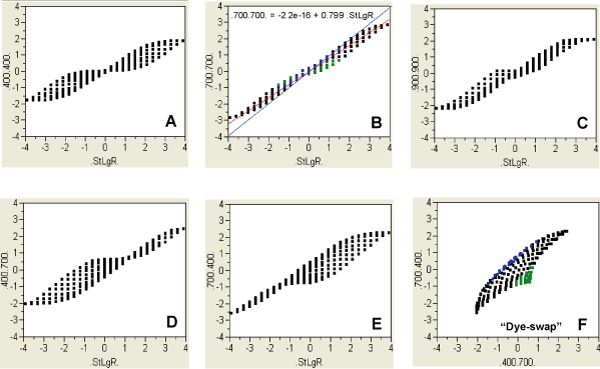
Accuracy and underestimation of log ratios. The correlation of true log ratios (StLgR) versus log ratios estimated by fluorescence intensities under different combinations of Cy5/Cy3 PMT gain settings reveals systematic ratio bias. Intensity data are mean-zero normalized for each individual channel at each PMT gain. The log ratios are estimated from different Cy5/Cy3 PMT gain combinations; A: 400 V/400 V; B: 700 V/700 V; C: 900 V/900 V; D: 400 V/700 V; and E: 700 V/400 V. Figure 5E corresponds to a dye-swap pair in which the Cy5/Cy3 PMT gains are set to 400 V/700 V and 700 V/400 V for the X- and Y-axes, respectively.